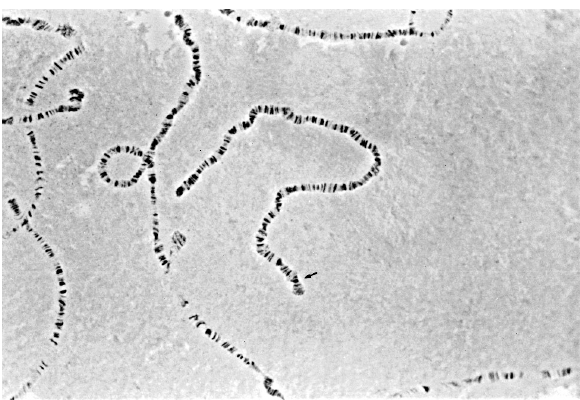
Figure2 -HomokaryotypesO st /O st ( Ba / Ba )obtainedinthecrossesamong Va / Ba individuals. The arrow indicates the distal tip of the chromosome, where the pattern of bands allows clear differentiation of the O st and the O 3+4 chromosomal arrangements.